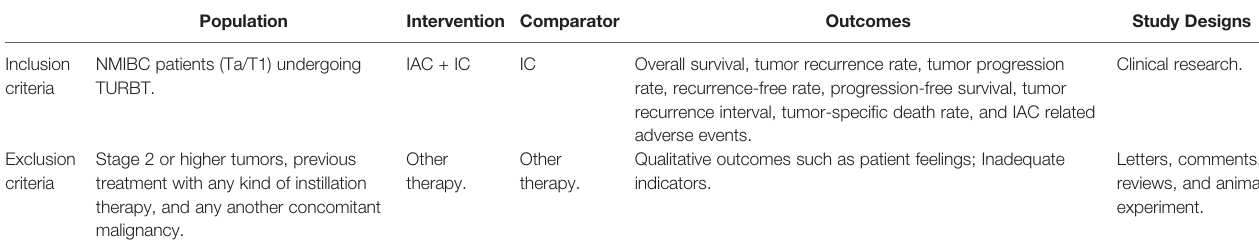
TABLE 1 | Criteria for included studies based on PICOS Structure.